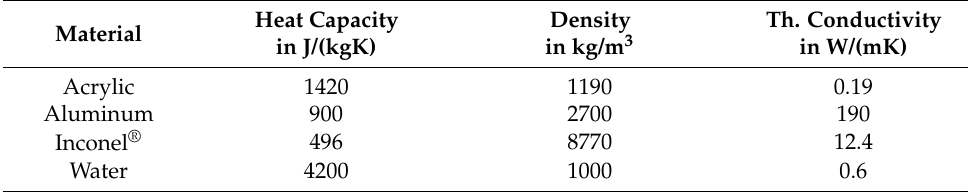
Table 5. Thermal–physical properties as applied in the FEM